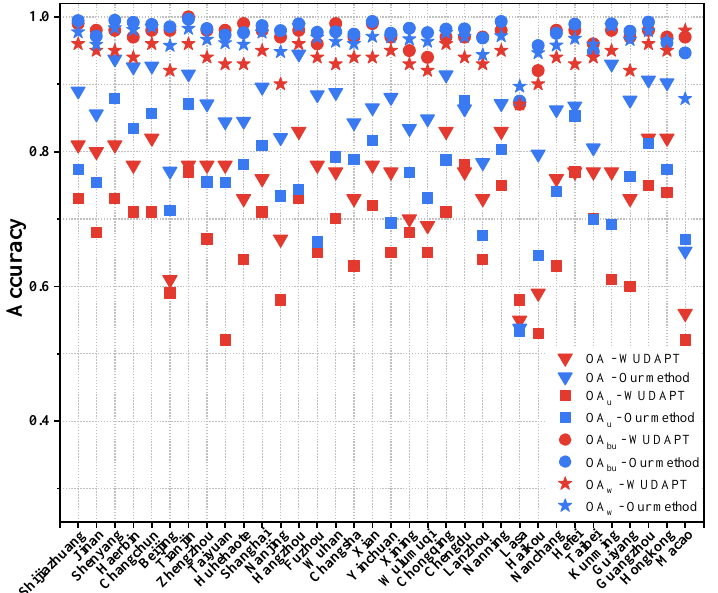
Figure 7. Comparison of four indicators (OA, OA u , OA bu , and OA w ) under two schemes (our method, S1; WUDAPT method, S2) for the 34 cities.